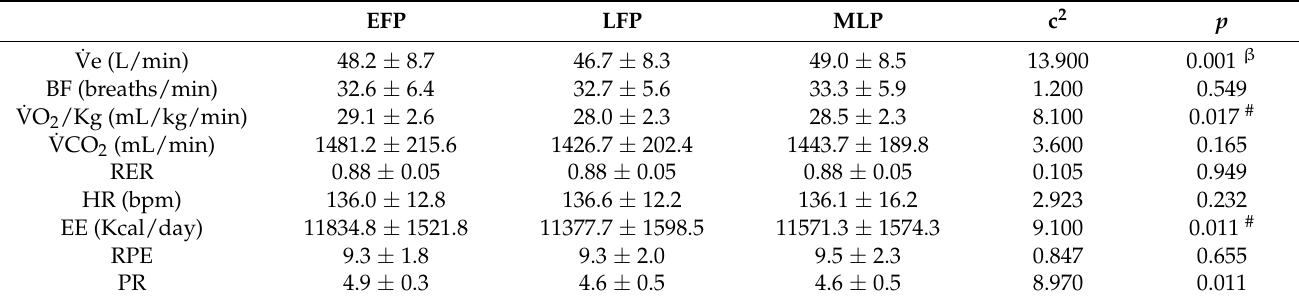
Table 2. Performance variables throughout the warm-up across the menstrual cycle